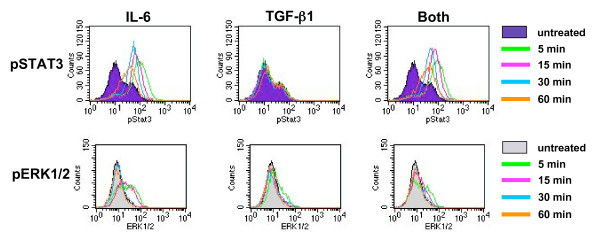
Activated (phosphorylated) STAT3 and ERK1/2 in LCL8664 cells treated with IL-6 and/or TGF-β1. LCL8664 cells were treated with IL-6 (20 ng/ml), TGF-β1 (1 ng/ml), both, or were untreated for time intervals between 0 – 60 minutes. Phosphorylated STAT3 (pSTAT3) and phosphorylated ERK1/2 (pERK1/2) were detected by intracellular flow cytometry.